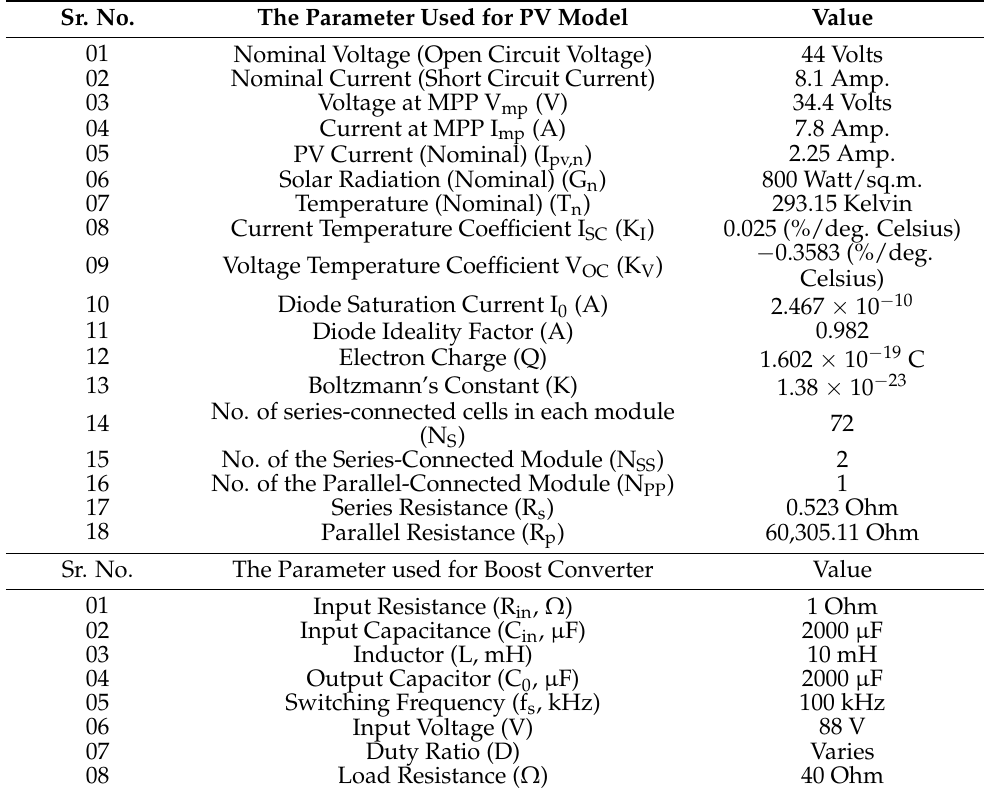
Table 3. Specifications of PV system.